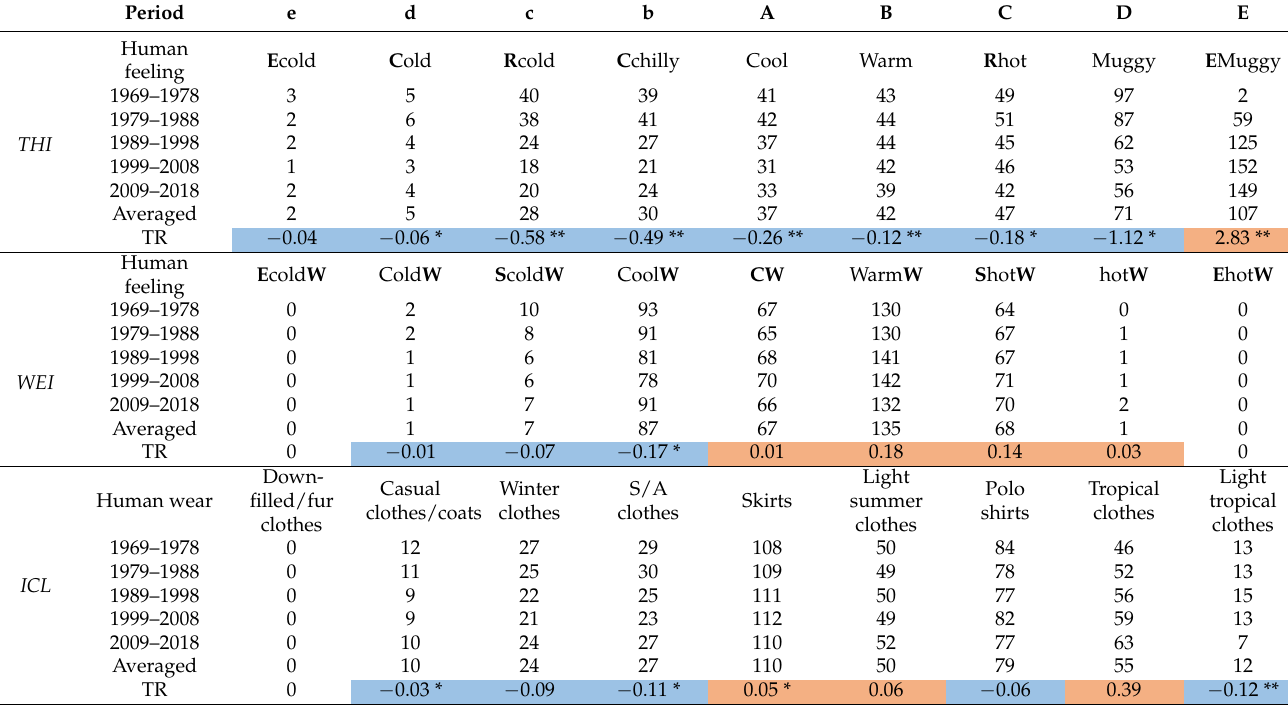
Table 3. Variation characteristics of phased comfort index from 1969 to 2018